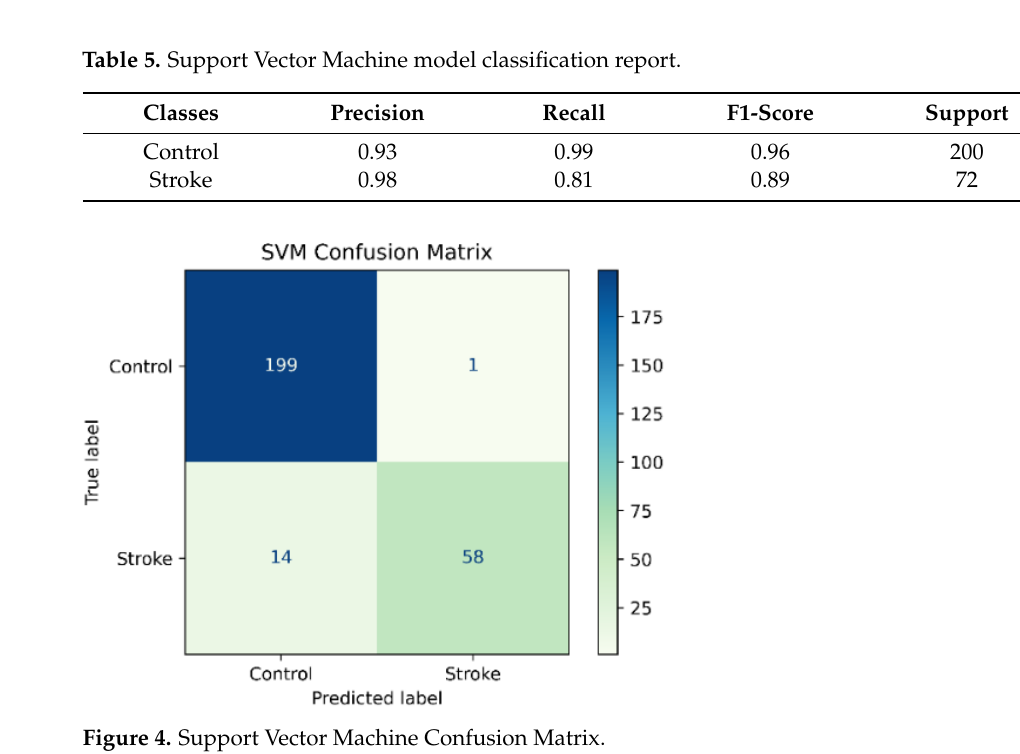
8 of 18 Figure 3. K-nearest Neighbor Confusion Matrix.